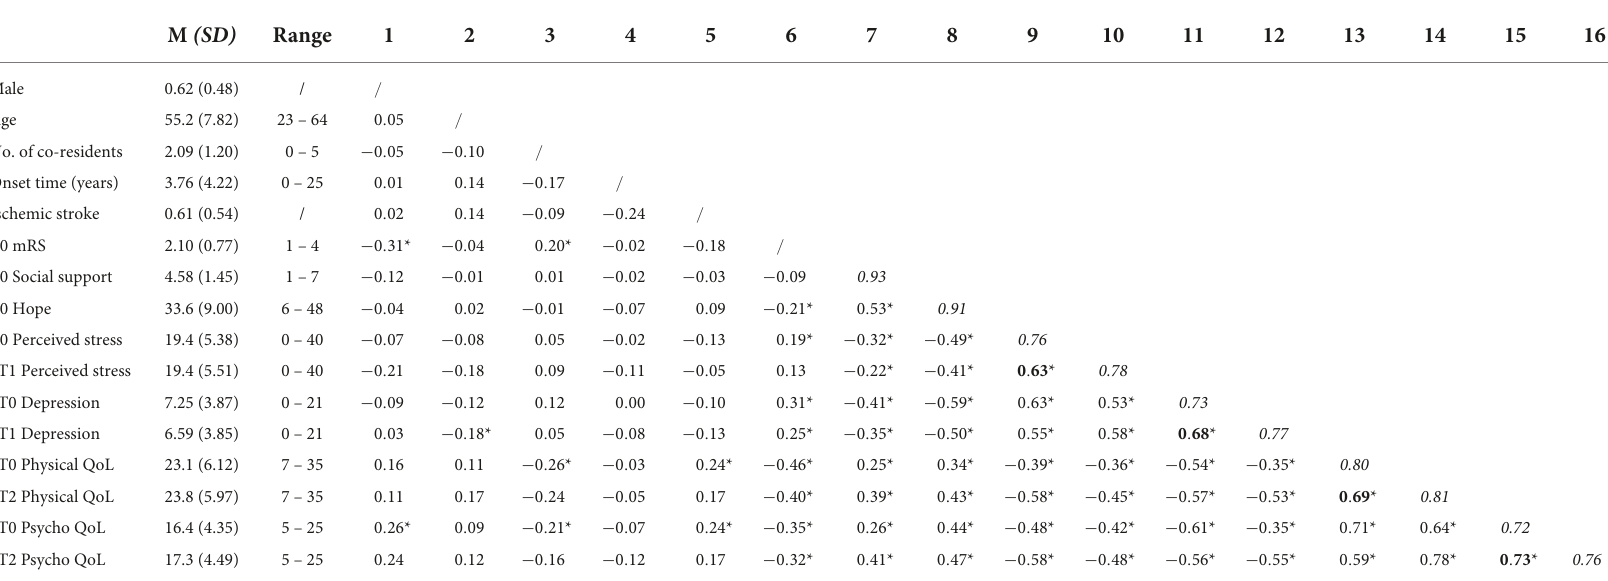
TABLE 1 Descriptive statistics, bivariate correlations, and reliability of the study variables across Time 0 and Time